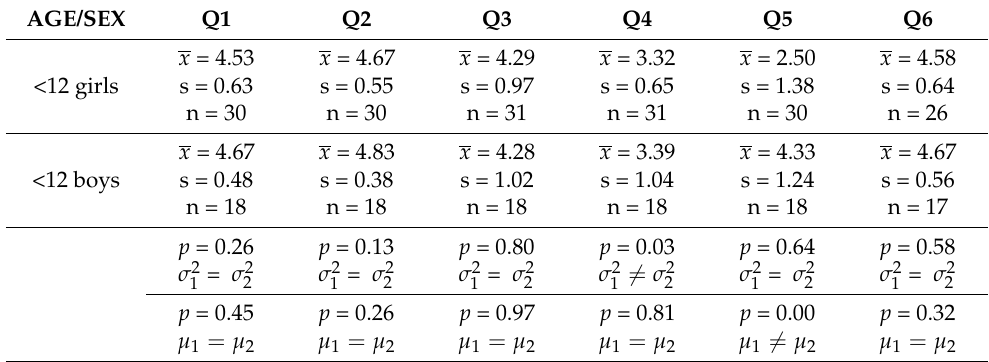
Table 4. Hypothesis test of variances and population means using chi-square and Student’s t -test distributions for girls and boys under 12 years of age (primary education).